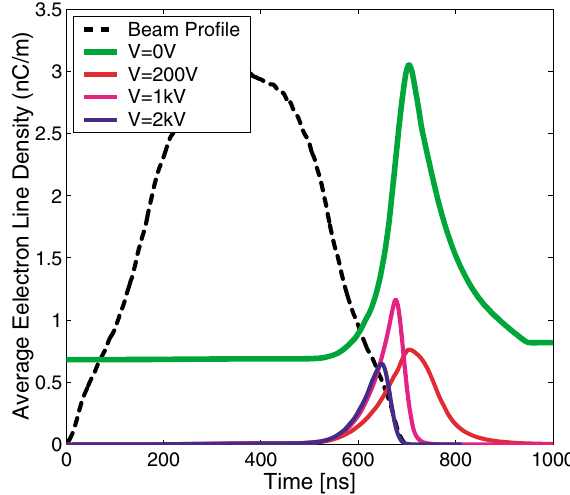
FIG. 10. (Color) Electron cloud buildup with various clearing voltages in the SNS’s dipole